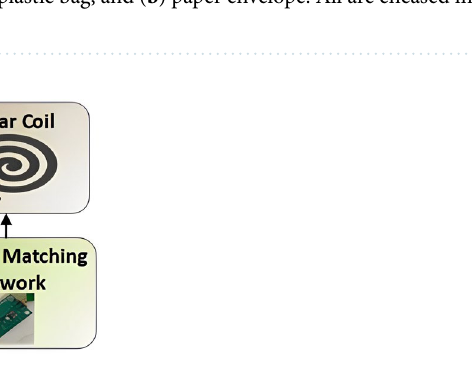
Figure 5. System-level block diagram of mail package authentication using NQR spectroscopy.